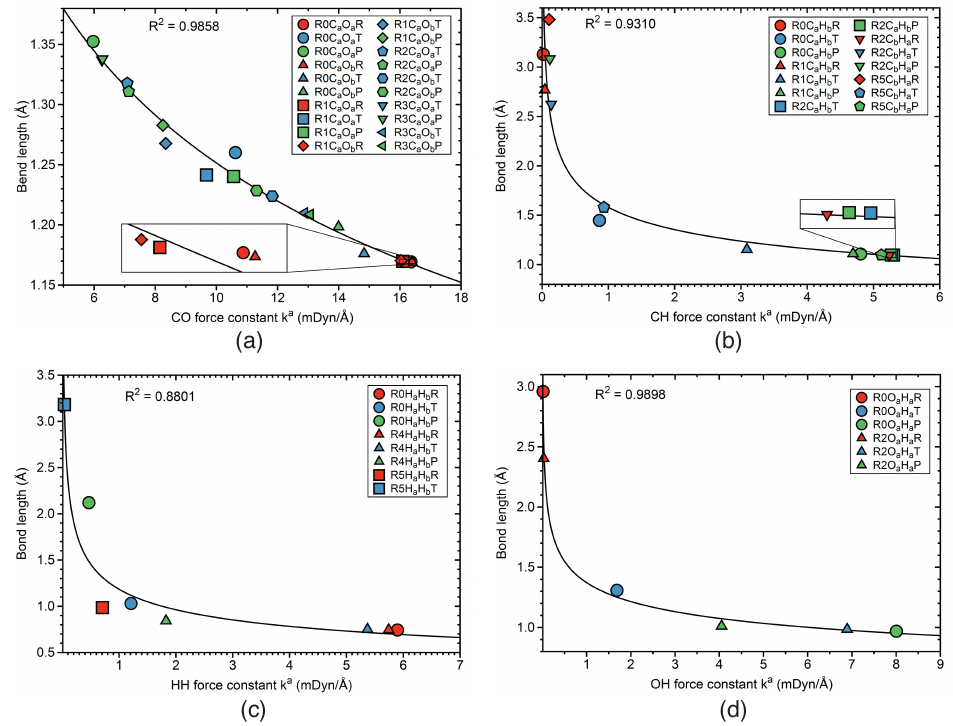
Figure 12. Correlation between bond lengths and local mode force constants. ( a ) CO bonds; ( b ) CH bonds; ( c ) HH bonds; ( d ) OH bonds. Labels such as R0C a O a R, R0C a O a T, and R0C a O a P indicate reactant RE (red color), TS (blue color), and product PR (green color) C a O a bond in reaction R0 . Similarly notation for reactions R1 – R5 . For the bond label description see the text. B3LYP/6- 31G(d,p)/SDD(Ir) level of theory.